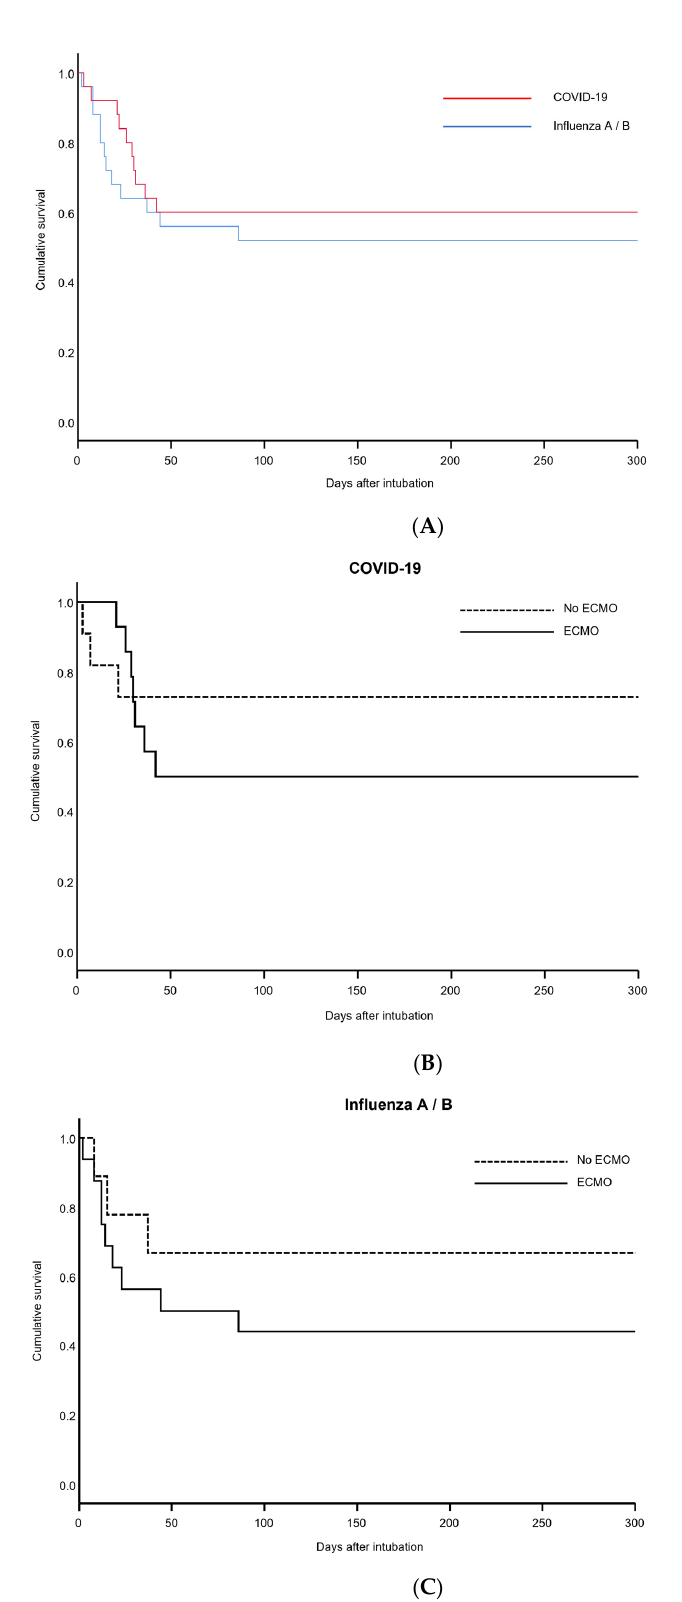
Figure 3. Kaplan–Meier plots for COVID-19 and Influenza patients. ( A ) Overall cumulative survival for COVID-19 and Influenza patients. ( B ) Subgroup analysis of cumulative survival for COVID-19 patients on ECMO and without ECMO. ( C ) Subgroup analysis of cumulative survival for Influenza patients on ECMO and without